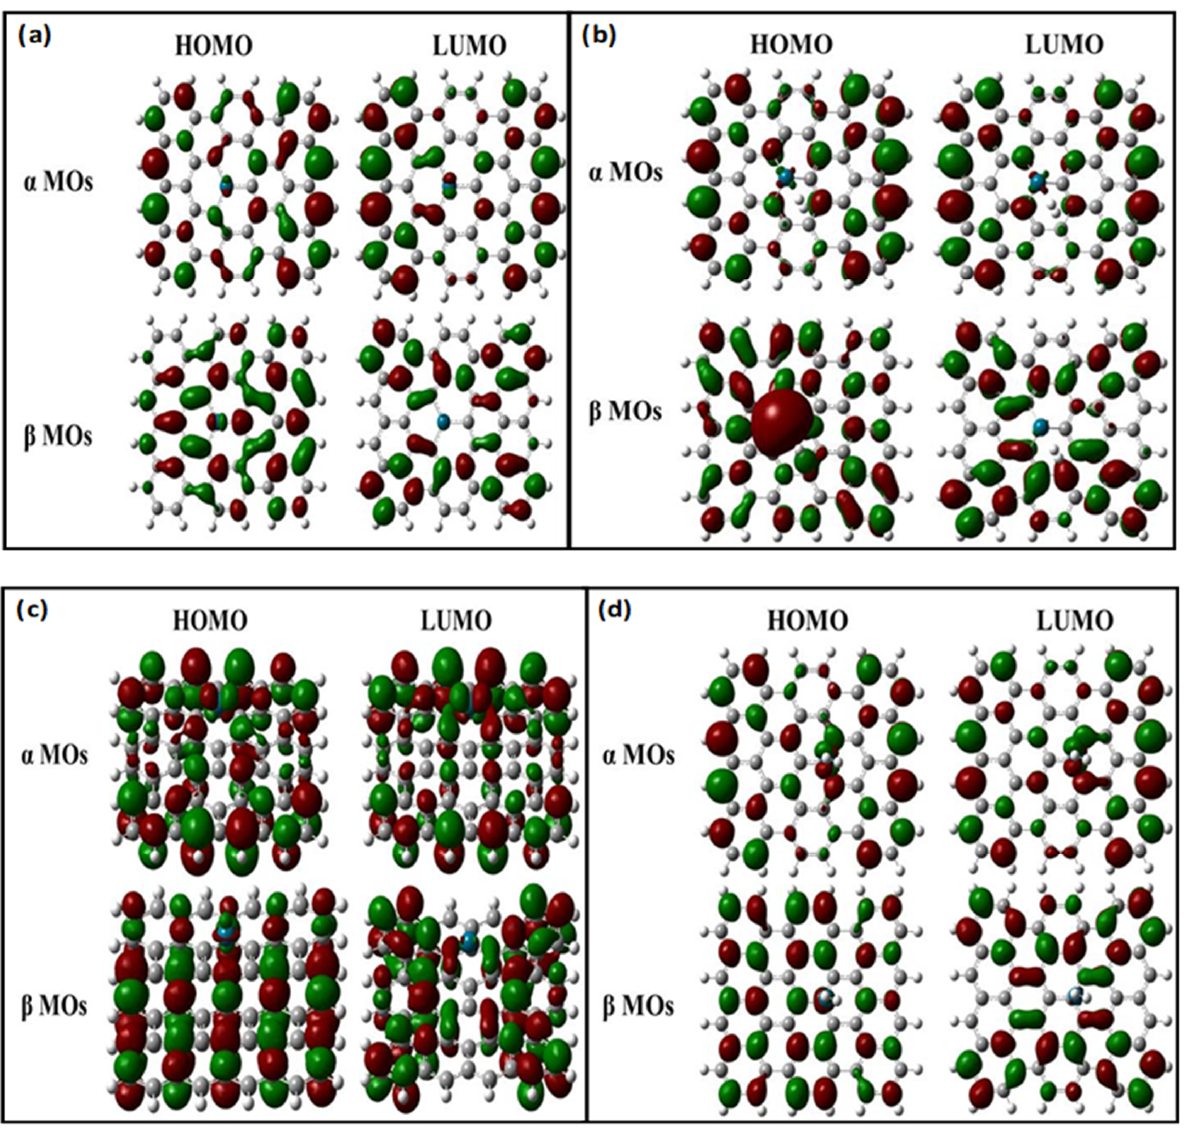
Figure 4. HOMO and LUMO representations of α and β MOs for the optimised structures of ( a ) Pd-doped graphene, ( b ) Pd-doped graphene-H 2 , ( c ) Pd-decorated graphene, and ( d ) Pd-decorated graphene-H 2